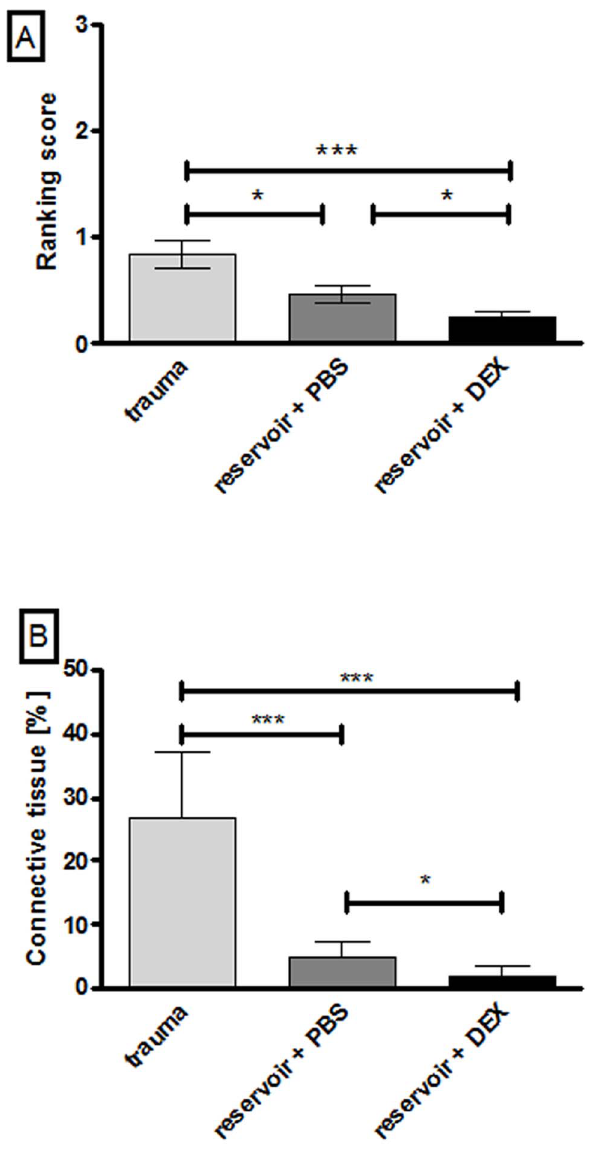
Figure 4. Graphed t-test results of tissue growth ranking (A) and measurement (B) for the whole cochlea length. Using both evaluation methods the tissue growth in the trauma group was significantly increased compared to the reservoir and DEX group with a p value , 0.001. When applying the ranking score the difference between reservoir + PBS and trauma or reservoir + DEX was significant with p , 0.05 (A). Comparing the tissue growth of the reservoir + PBS group with those of the trauma group or the DEX group using the measuring method, the p value is , 0.001 (PBS vs. trauma) and , 0.05 (PBS vs. DEX). Error bars: SEM. *=p , 0.05, ***=p , 0.001.